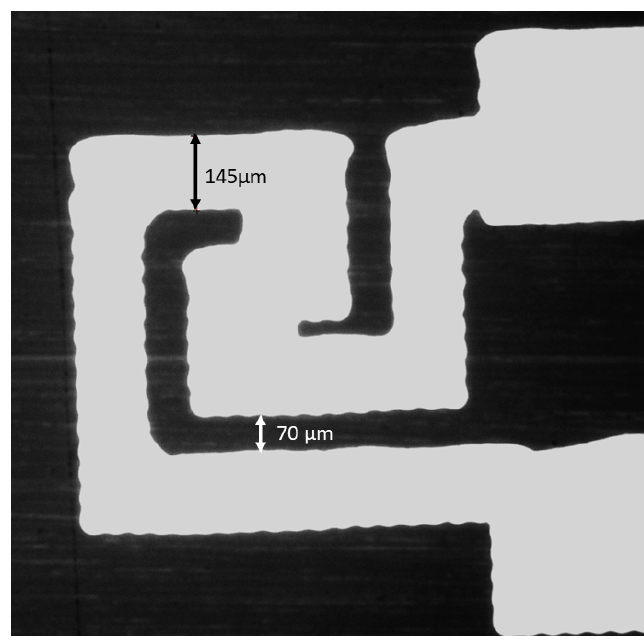
Figure 9. Measurements of Track Width and Gap